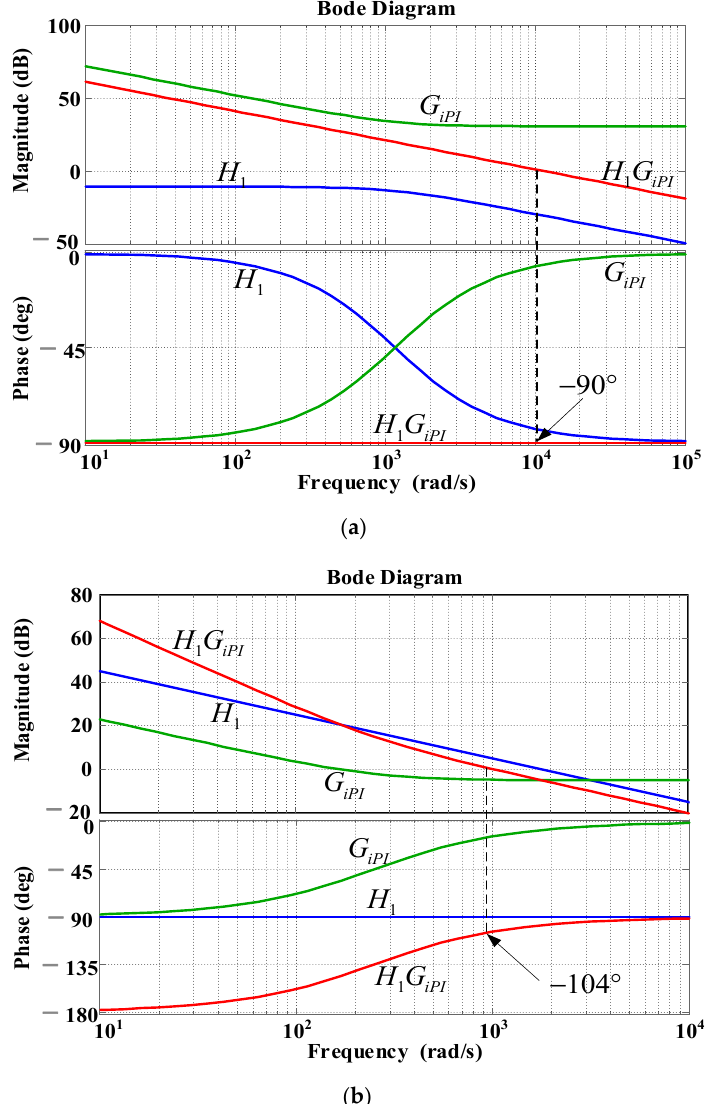
Figure 8. Bode plots of designed controller: ( a ) inner loop current controller; ( b ) DC voltage control- ler.